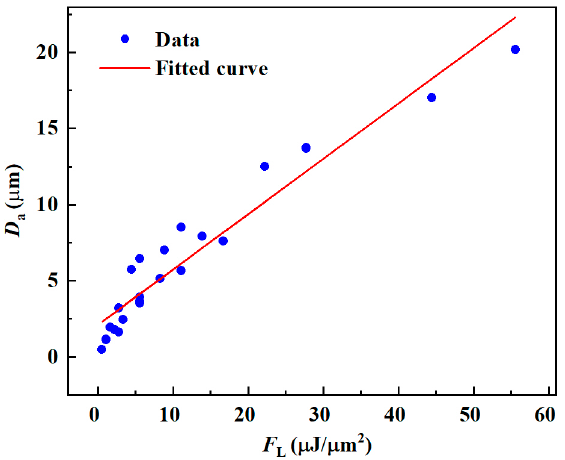
Figure 11. The average ablation depth D a of the microgroove changes with the F L .